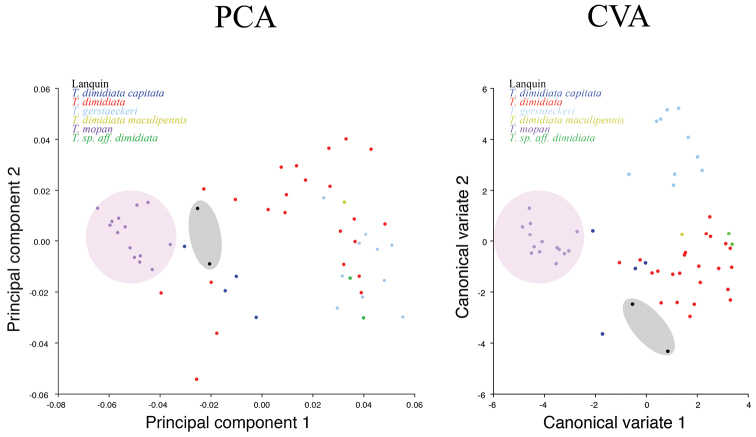

PCA and CVA of the Morphometric comparison of the heads of T.
mopan, T.
gerstaeckeri, Triatoma from Lanquin and T.
dimidiata different morphotypes. Note that both T.
mopan and Triatoma from Lanquin form clusters separated from the other species.